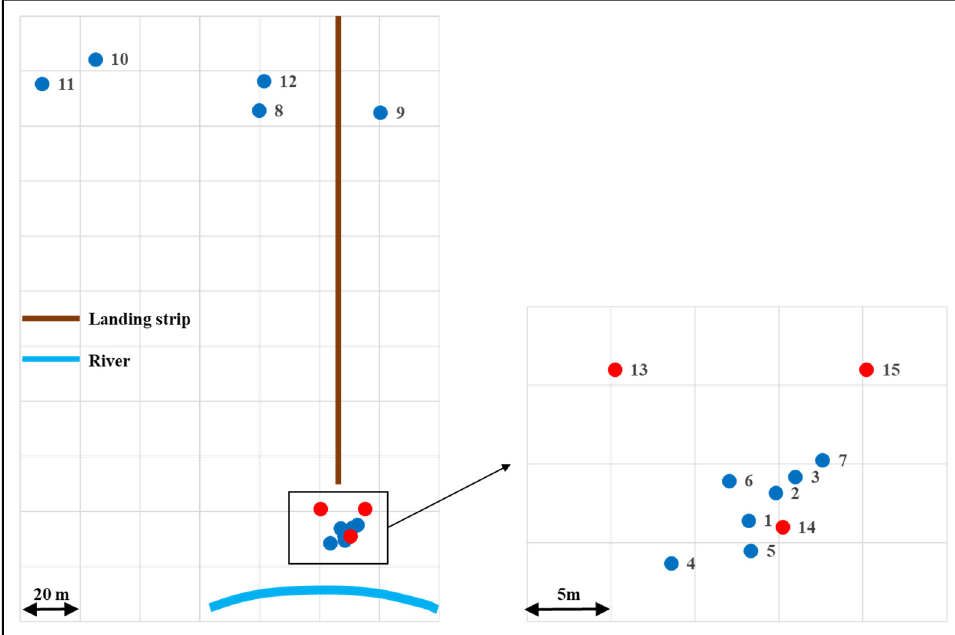
Figure 4. Demand and potential generation points in Suraka. Numbers refer to the households (blue) and potential generation points (red).